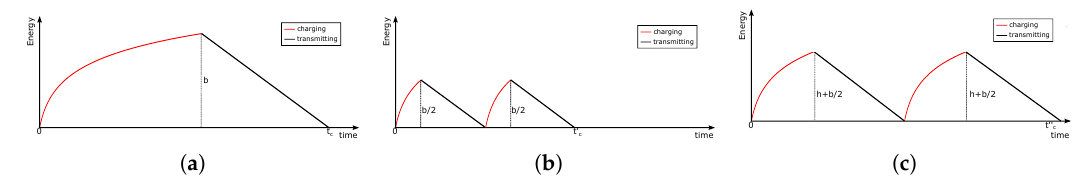
Figure 3. Find the minimum total transmission time. ( a ) transmit the data in one packet; ( b ) transmit the data in multiple smaller packets; ( c ) extra transmission cost of introducing the packet